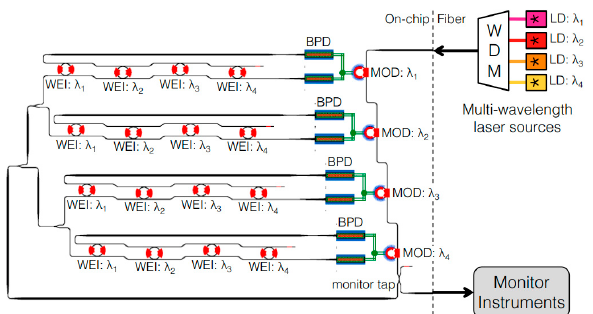
Figure 3. MRR wavelength division multiplexer [26]. MRR is mainly responsible for the weight configuration of neural network, and the red part indicates that the weight can be changed through the external environment. The whole network is integrated except for bit pumped lasers.